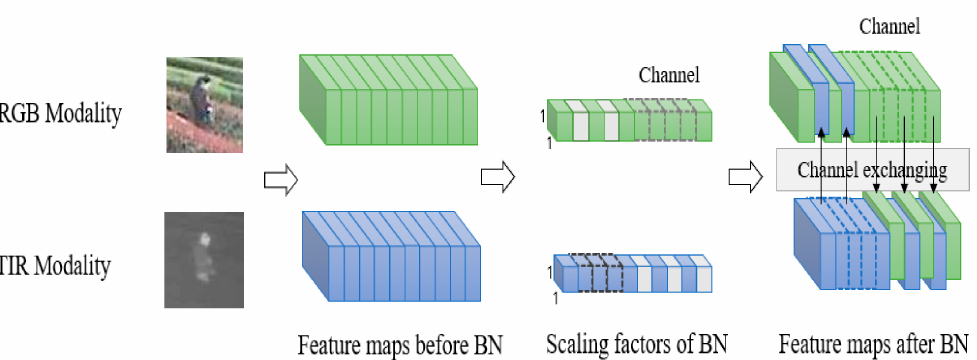
Figure 4. RGB and TIR dual-modal channel exchanging